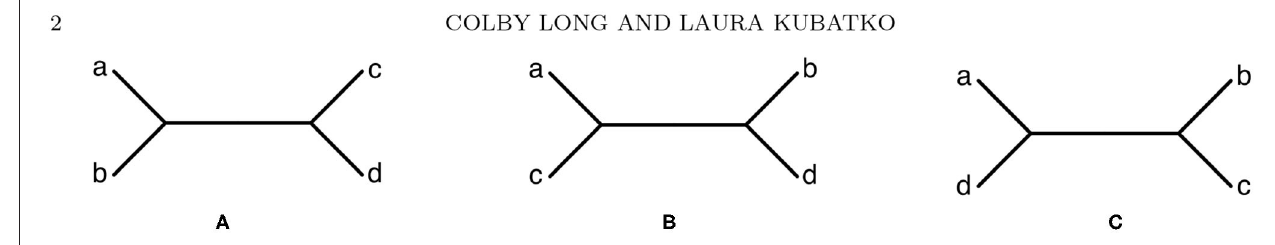
FIGURE 1 | The three possible unrooted tree topologies for four taxa. (A) Tree T 1 , (B) Tree T 2 , and (C) Tree T 3 .